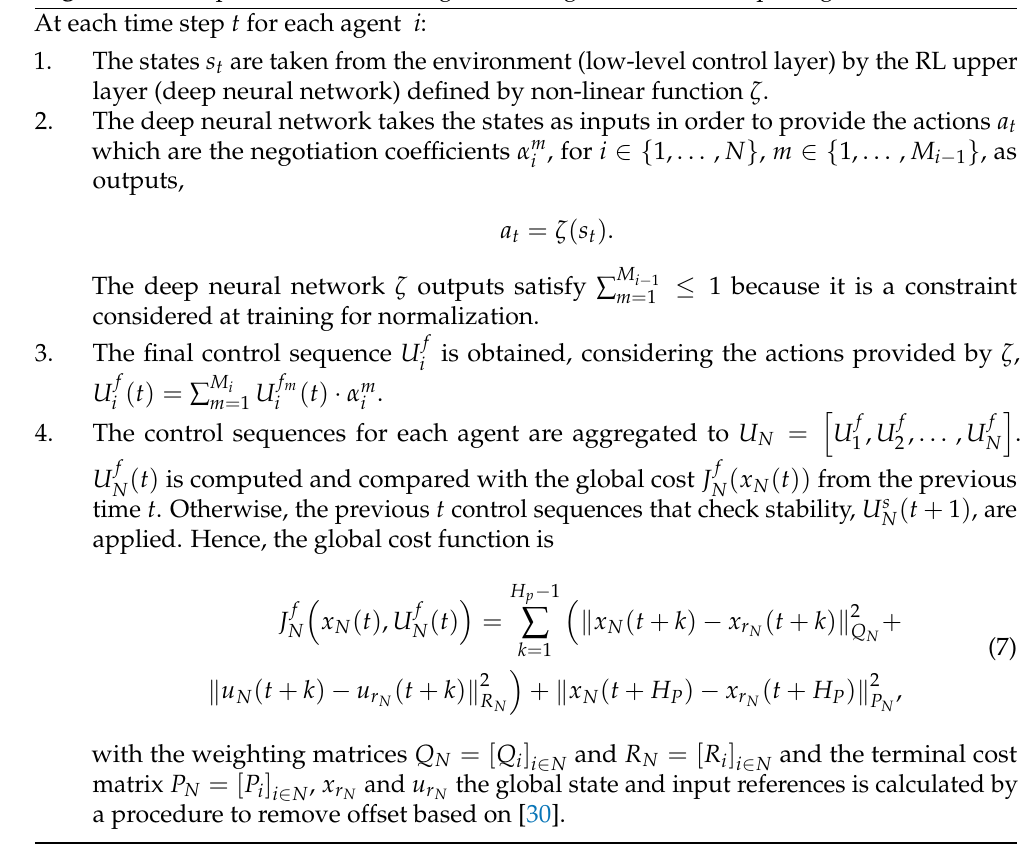
Algorithm 1 Proposed PG-DMPC negotiation algorithm for multiples